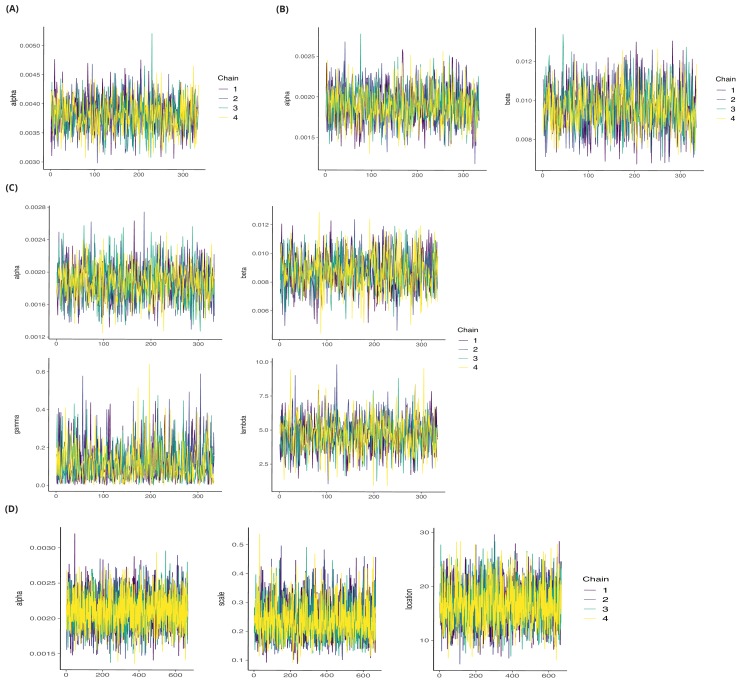
Posterior chains from Hamiltonian Markov chain Monte Carlo fitting for Klebsiella transmission models (see Table 3).(A) Transmission model 1; intercept [alpha] R^=1.001, ESSbulk = 1359, ESStail = 1171. (B) Transmission model 2; alpha and beta; R^ ranges from 1.001 to 1.002, ESSbulk ranges from 1144 to 1298, ESStail ranges from 1247 to 1282. (C) Transmission model 3; alpha, beta, gamma and lambda. R̂ ranges from 1.000 to 1.003, ESSbulk ranges from 1274 to 1396, ESStail ranges from 1180 to 1285. (D) Transmission model 4. alpha and beta hyper-parameters scale/shape 1, location/shape two and transmission parameters for each ST (62, not shown), R^ ranges from 0.999 to 1.003, ESSbulk ranges from 1687 to 2887 and ESStail ranges from 2105 to 2796.